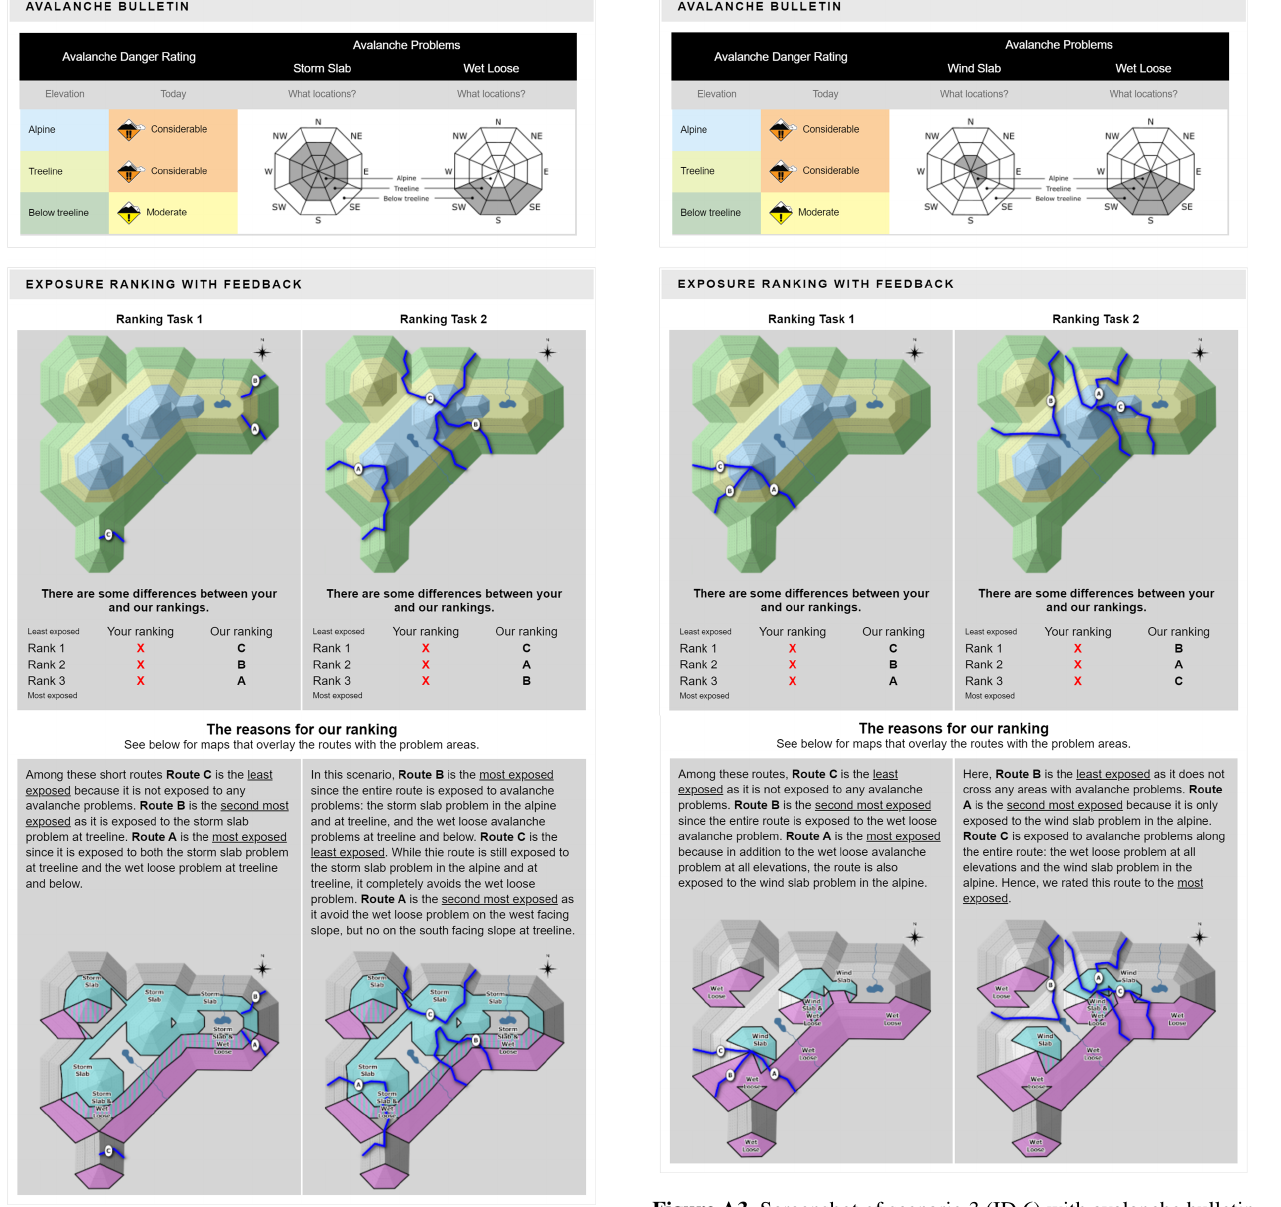
Figure A3. Screenshot of scenario 3 (ID 6) with avalanche bulletin information, route options, ranking solutions, and